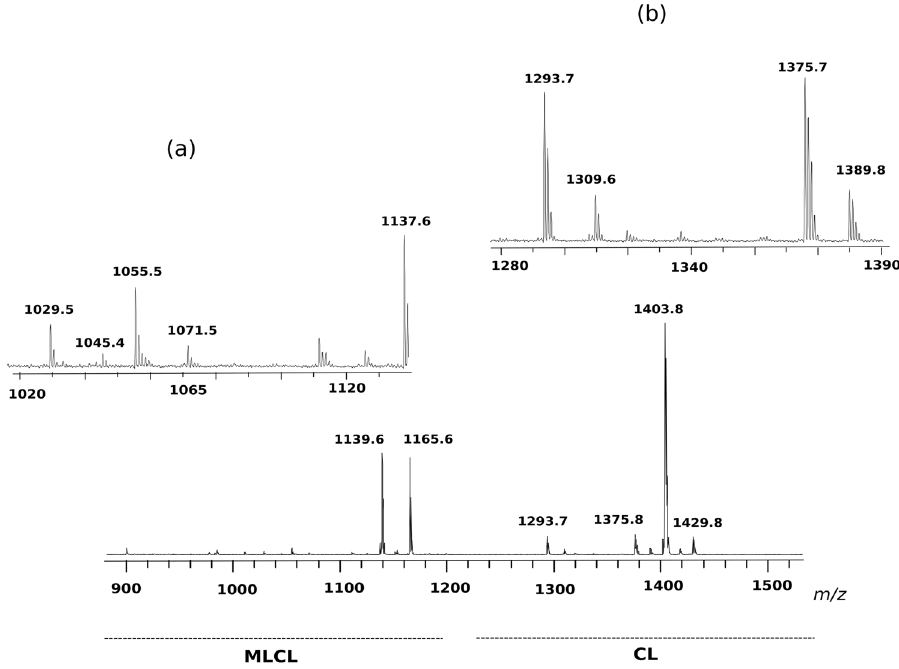
Figure 6. MLCL and CL fingerprint of intact membranes of Acinetobacter baumannii , acquired by MALDI- TOF/MS analyses. ( a ) m/z range of MLCLs; ( b ) m/z range of